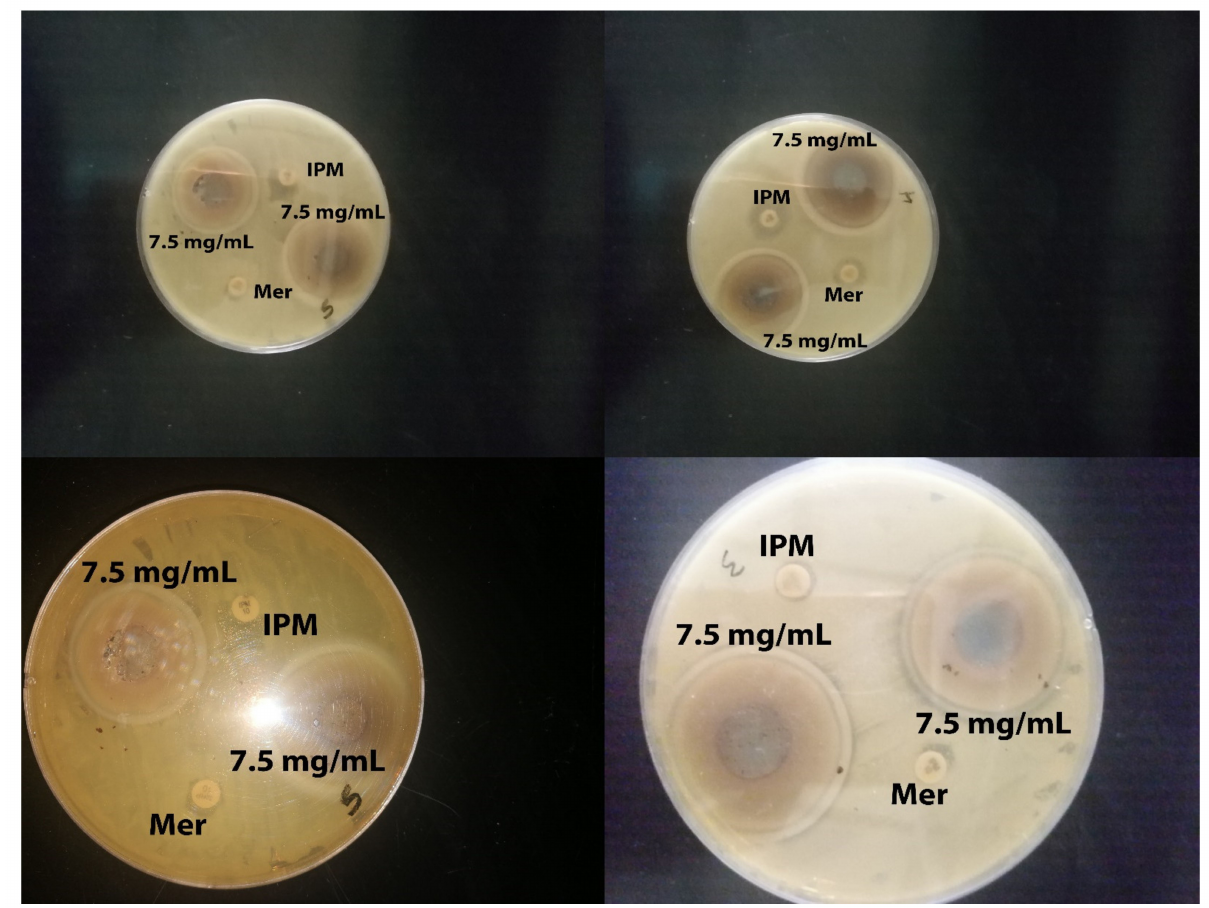
Figure 4. Zone of inhibition of ZnO-NPs against KPC at concentrations of 7.5 mg/mL. Controls: imipenem and meropenem. Zinc oxide nanoparticles showed high antibacterial potential against KPC and Kleb- siella pneumoniae (ATCC 700603). The samples’ antimicrobial activities were evaluated